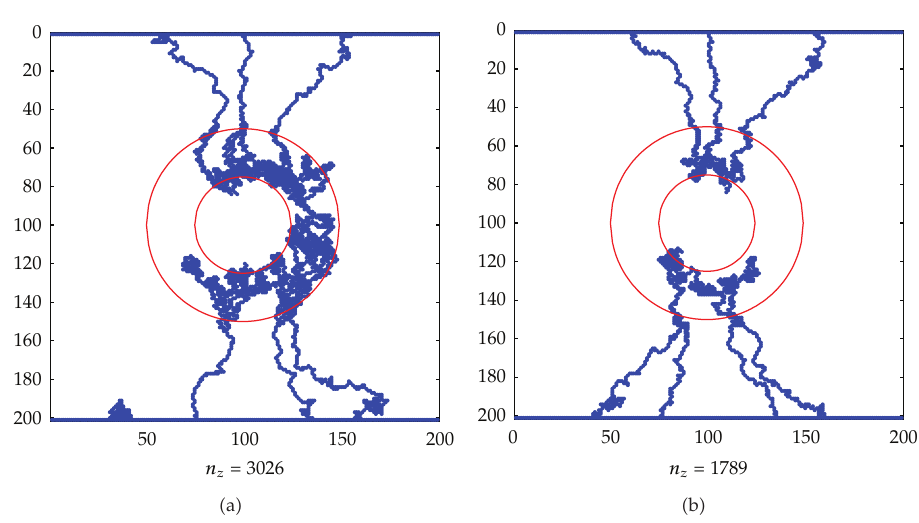
Figure 2: The vasculature for flow simulations; the blue lines on top and bottom of lattice represent the parent vessels, and the big red circle represents the tumor domain. (cid:2) a (cid:3) The tumor vasculature without antiangiogenesis therapy; (cid:2) b (cid:3) the tumor vasculature under antiangiogenesis